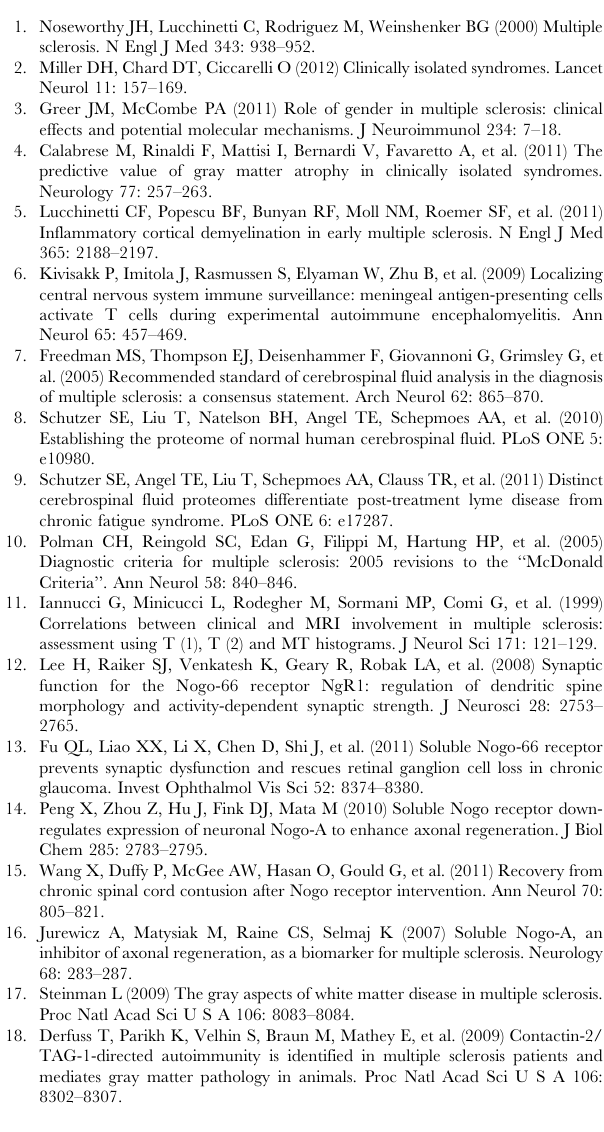
Table S1 Proteins Identified or Not in MS Patients Com- pared to Normals and Other Neurologic Disease (OND). Table S2 Proteins with significant difference in abun- dance by ANOVA (p-value ,